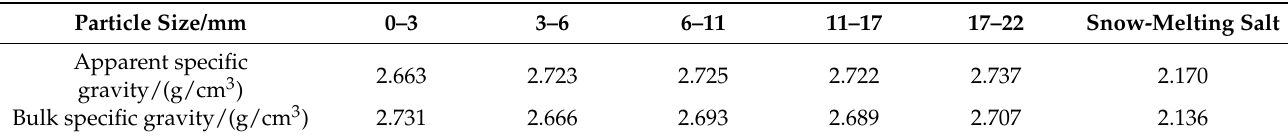
Table 6. Density of aggregate and filler.